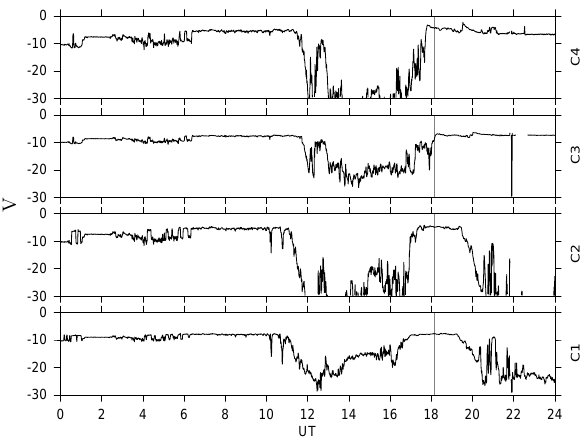
Fig. 3: EFW probe potential on 21 January 2003. Fig. 3. EFW probe potential on 21 January